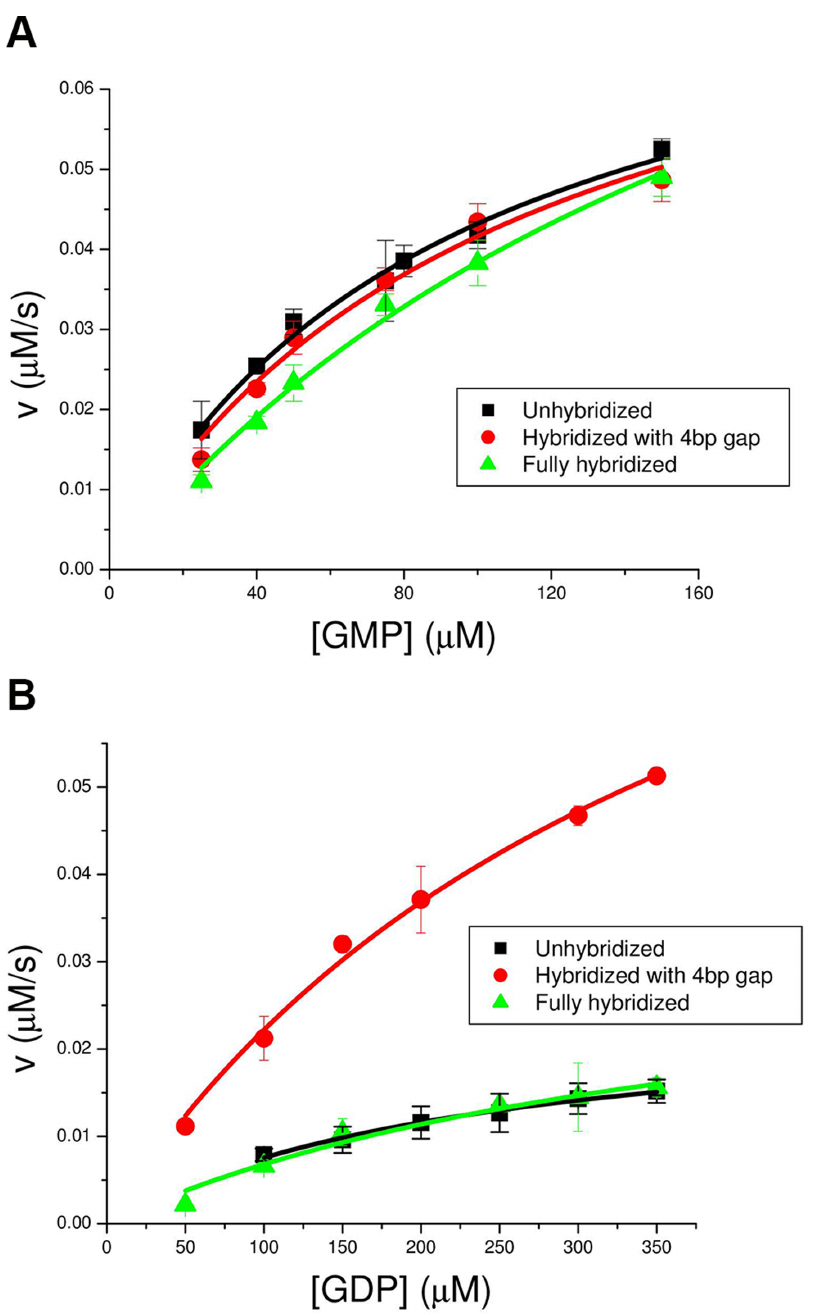
Figure 4. ‘‘High Mg’’ titration curves (initial reaction speed vs. initial substrate concentration) for the yeast GK chimera in the absence (circles) and presence (triangles) of mechanical stress. Circles: double-stranded DNA spring with a 4 bp central gap; triangles: double-stranded DNA spring with no gap or nick. Squares: ssDNA spring. Titrations were performed under "high salt" buffer conditions: 300 mM KCl and 30 mM MgCl 2 . a) GMP titration curves for the forward reaction. Conditions were the same as in Fig. 3: enzyme concentration was * 7 nM and and initial ATP concentration was 400 m M. b) GDP titration curves for the reverse reaction. Enzyme concentration was * 20 nM and initial ADP concentration was 400 m